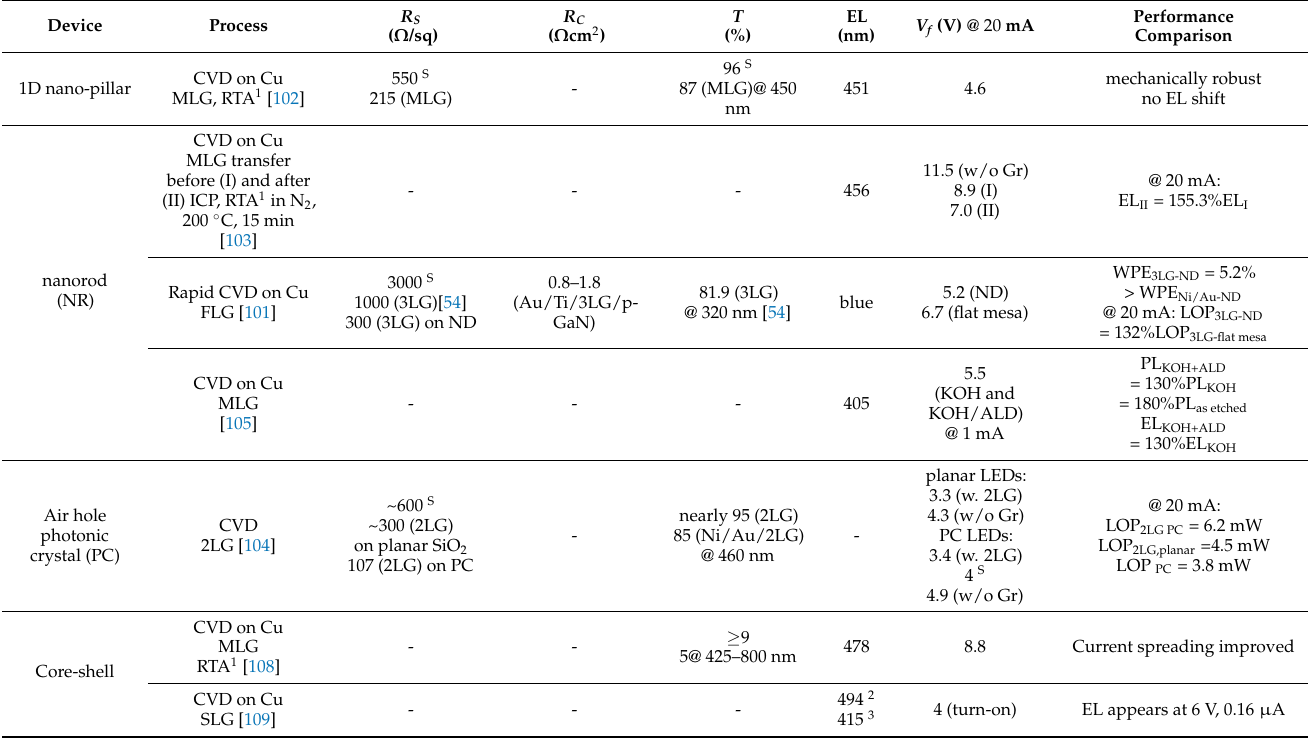
Table 7. Usage of graphene as TCSL used in advanced GaN-based